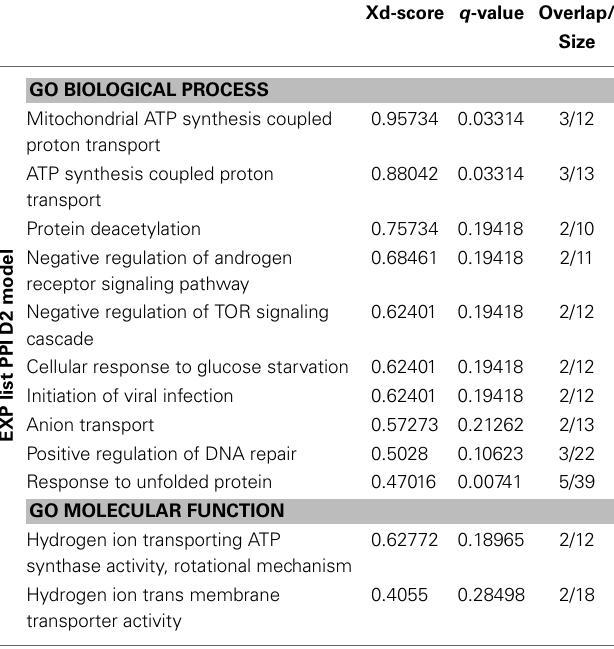
Table 2 | Summary table of most significant results of the Jepetto analysis of EXP list, PPI D2 model.